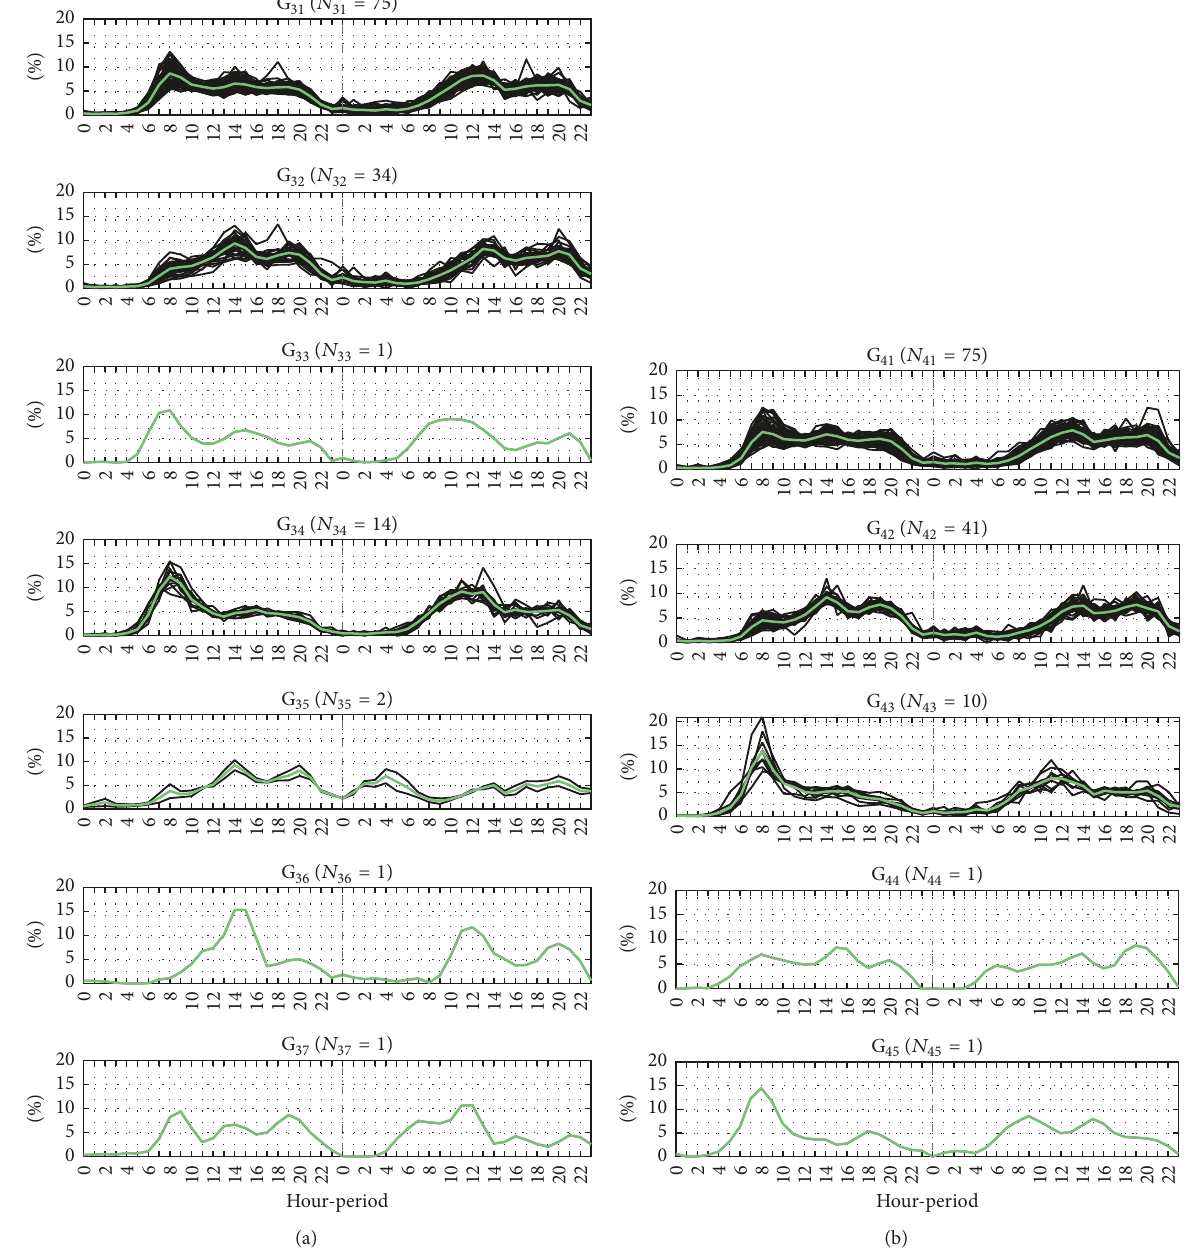
Figure 2: Weekday (left)-weekend (right) patterns by the hour period associated with (a) the departure time from a given zone and (b) the arrival time at a given